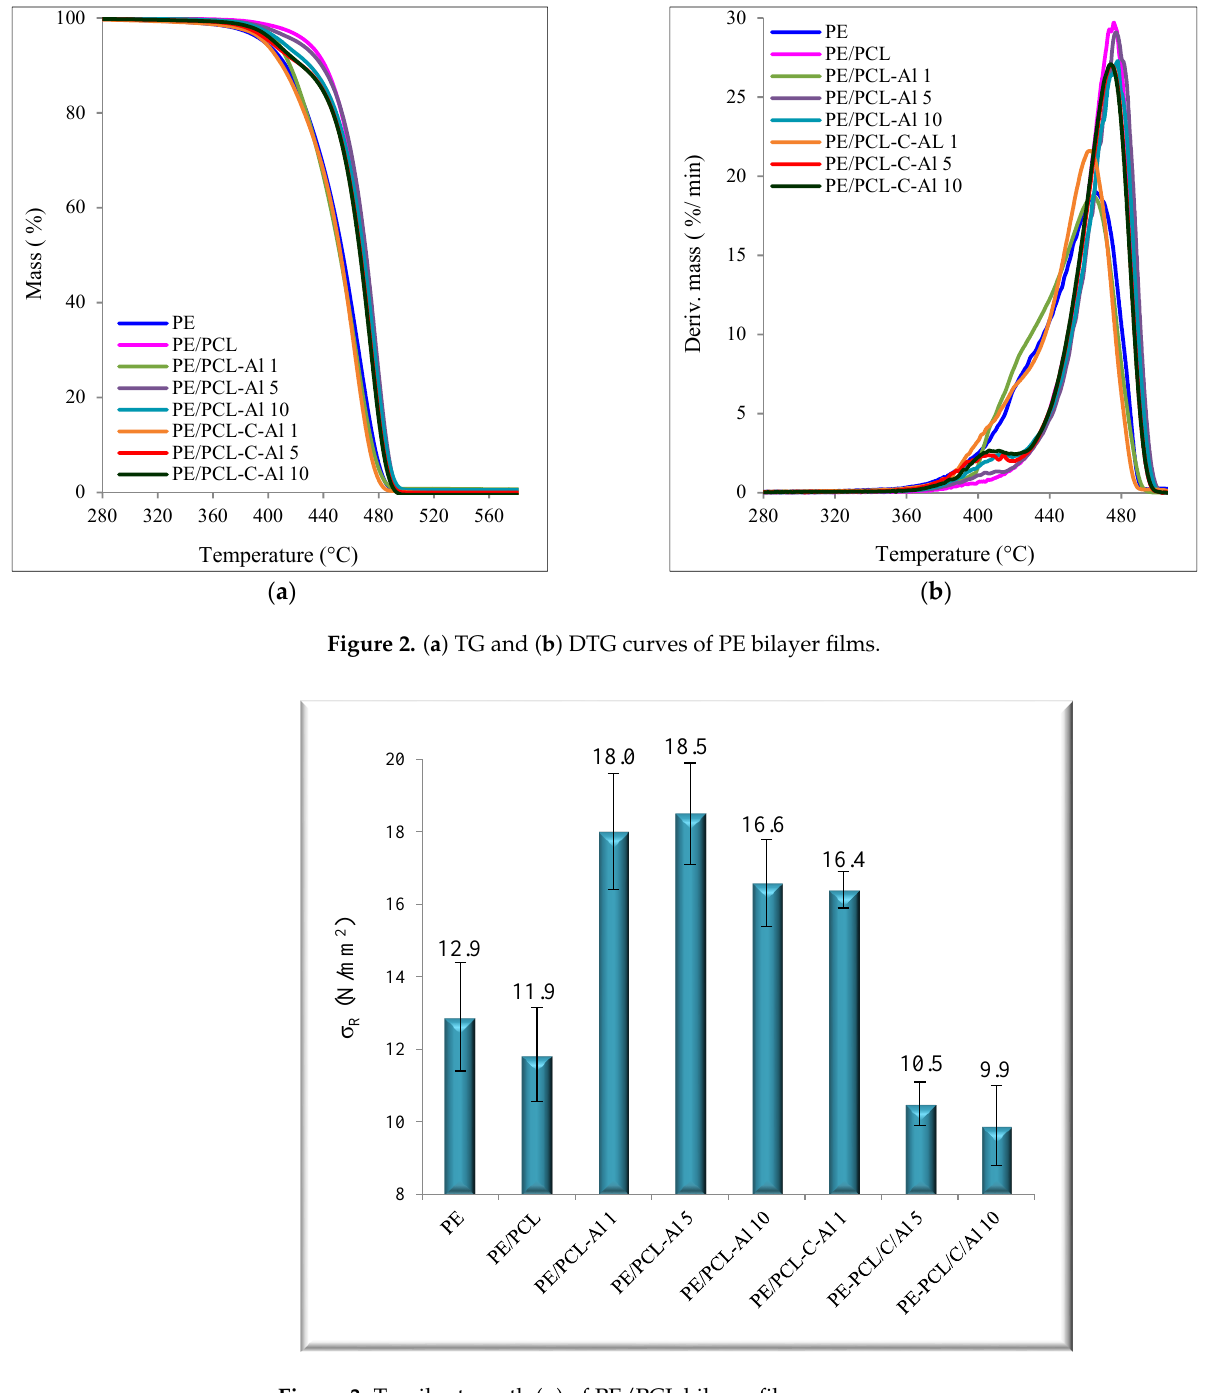
Figure 4. Elongation at break (ε) of PE/PCL bilayer films . Nevertheless, the mechanical properties of PE/PCL samples prepared with ca- sein/aluminum oxide significantly decreased with the increase of Al 2 O 3 ratio. The lowest values of elongation at break and tensile strength were shown in the PE/PCL-C-Al 10 sam- ple, indicating poor interaction between the components, which could result in inhomo- geneous distribution of particles and/or presence of agglomerates in a polymer matrix. The interphase between a polymer and a filler often acts as a “weak point” in the polymer material and causes premature breakage. Therefore, it is important to ensure good disper- sion of each component in the polymer matrix and prevent the formation of agglomerates that markedly weaken the mechanical properties [34].